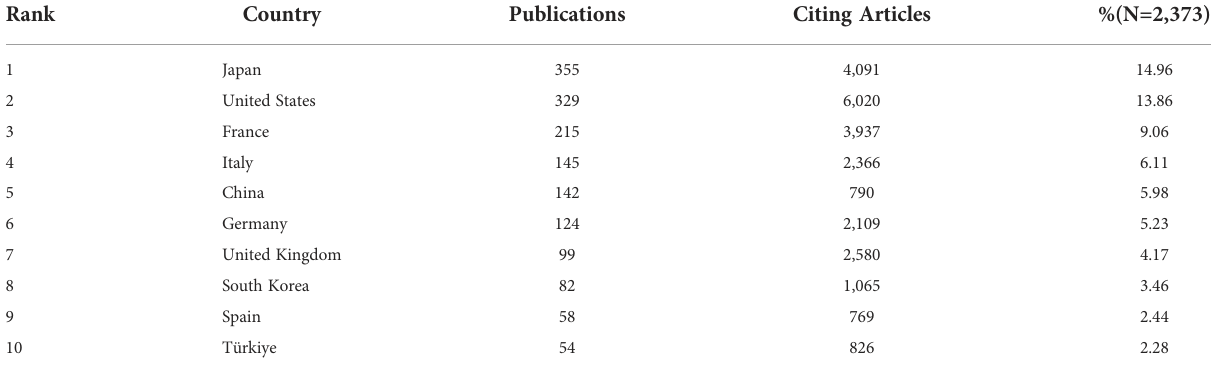
TABLE 5 Top 10 countries/regions with the largest number of articles from 1921 to 2021. Rank Country